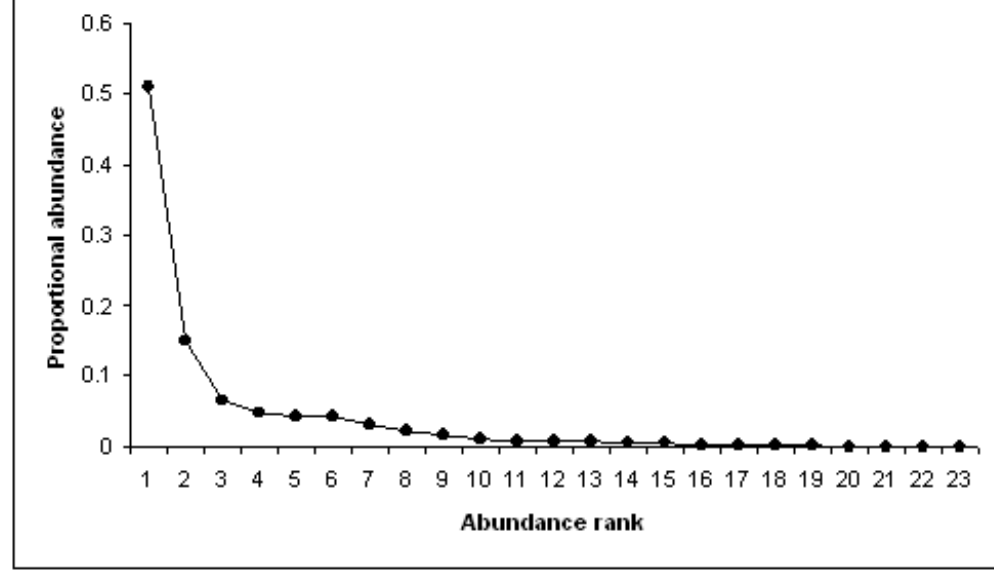
abundanceFigure 1. Proportional abundance distribution of different species in rank abundance